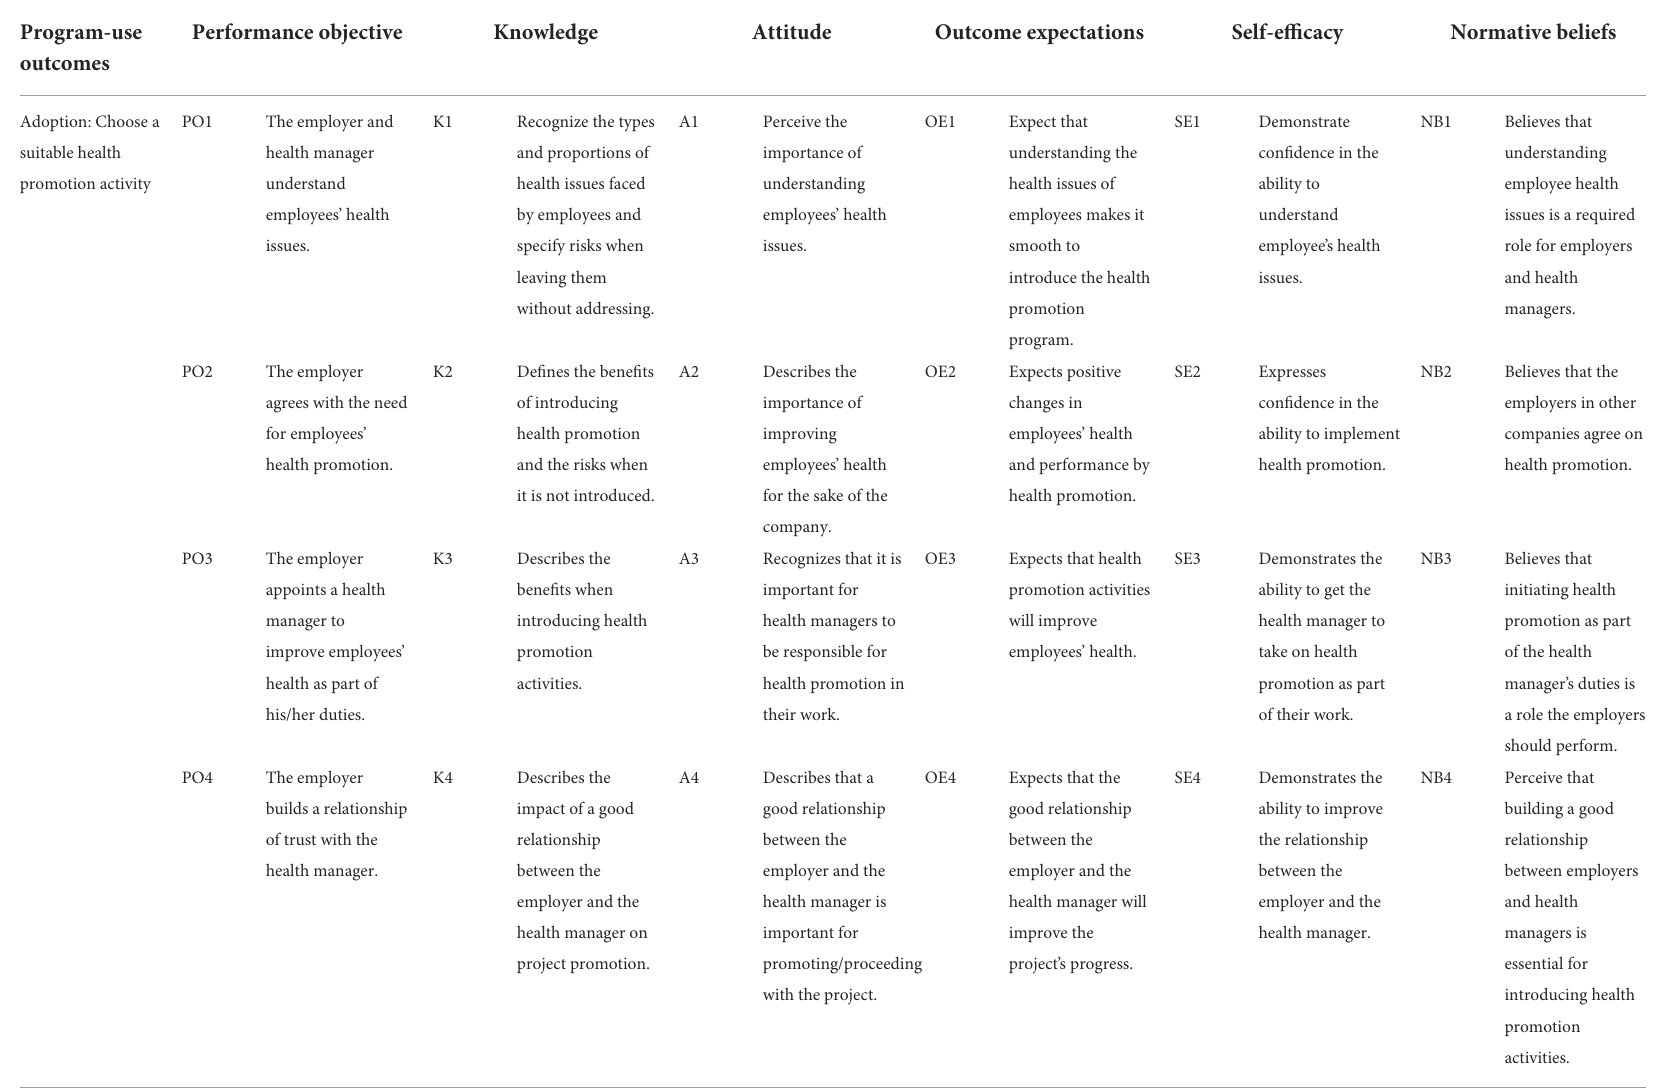
TABLE 1 Implementation Mapping process Task 2: Adoption.